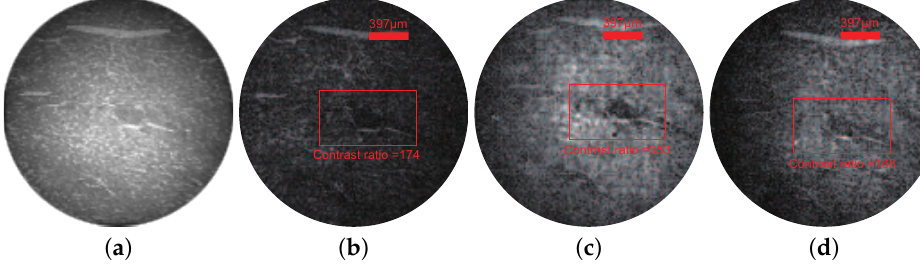
Figure 5. Single-pixel multi-spectral microscopic imaging of liver cancer section. ( a ) The sample image photographed by Charge Coupled Device (CCD) under white light illumination. ( b – d ) Single- pixel microscopic imaging under white light (440–670 nm), red light (621 nm) and blue light (451 nm) respectively.